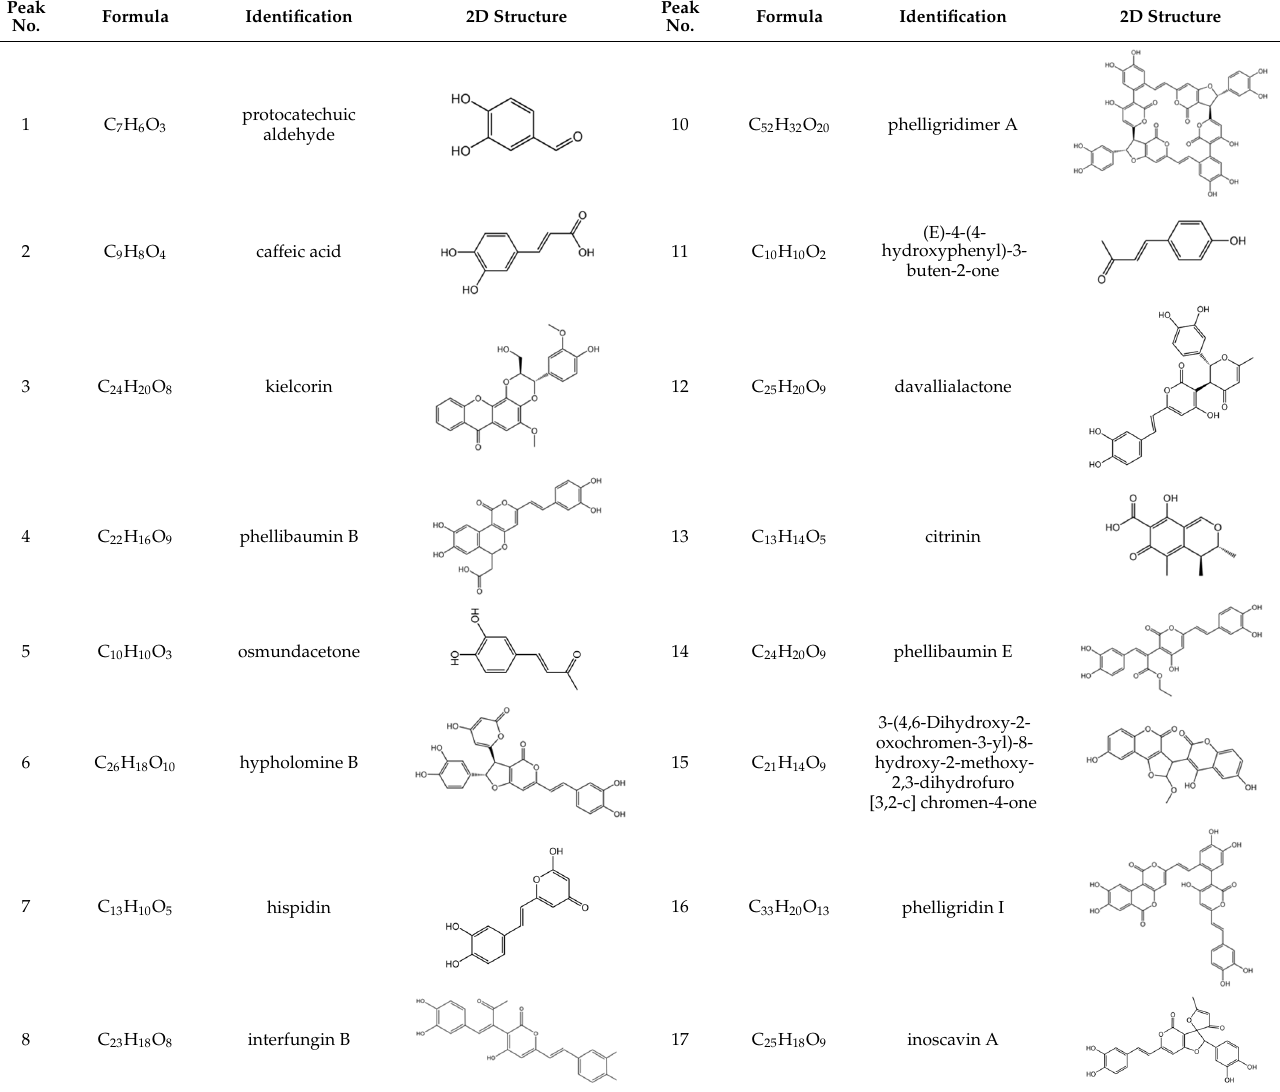
Table 1. Characterization of the chemical constituents of PBP by UPLC–ESI–QTOF–MS. Peak No.